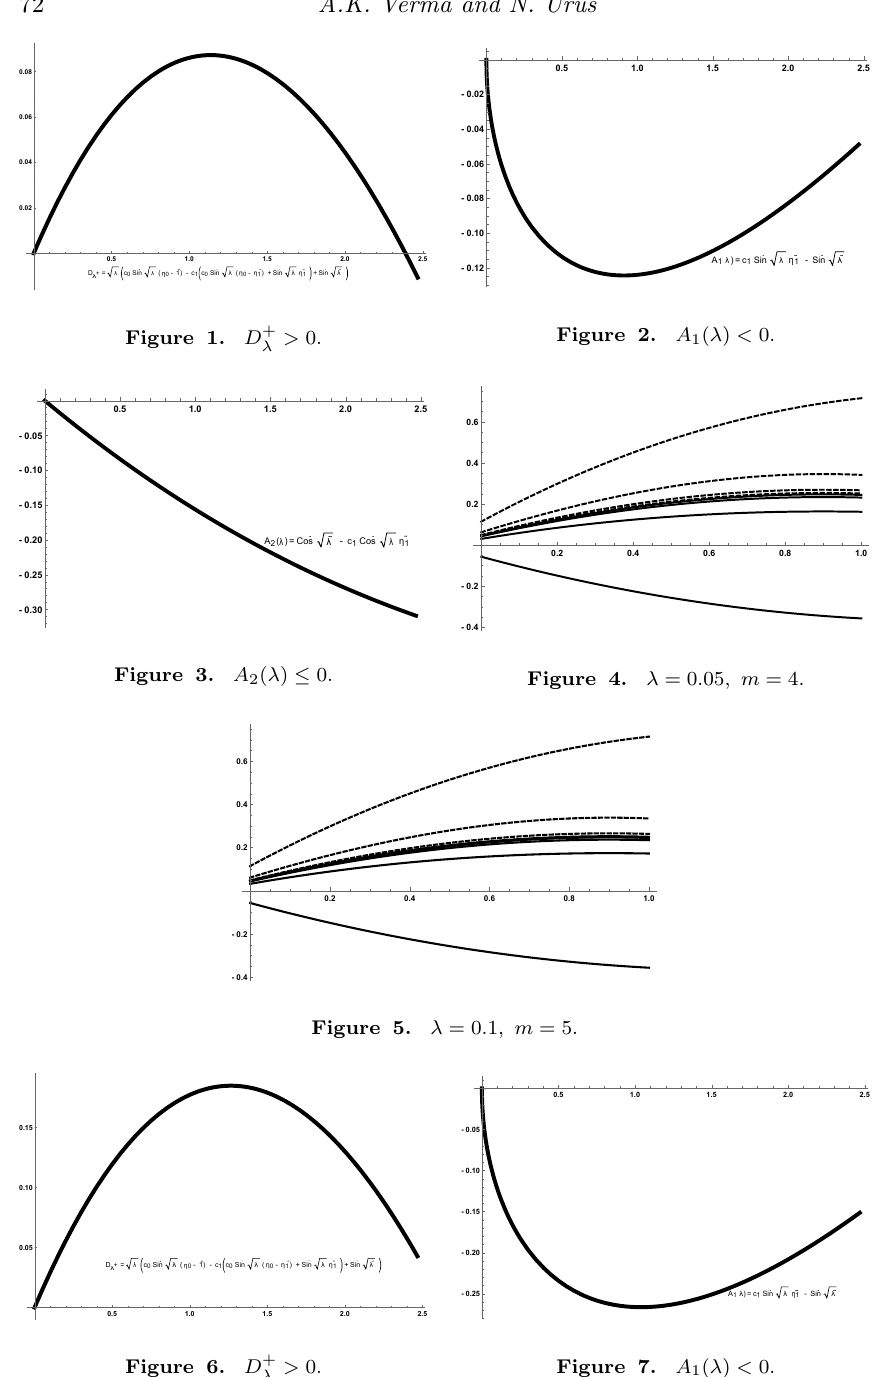
Figure 6. D + > 0 . Figure 7. A 1 ( λ ) < 0 λ